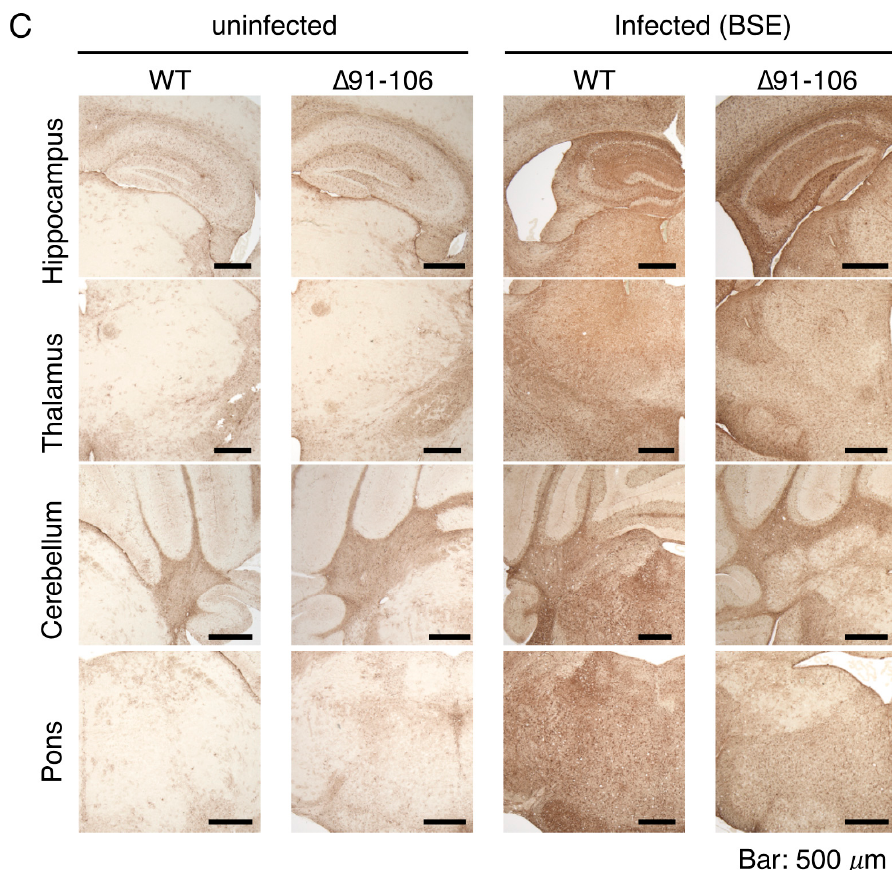
Figure 4. Pathological examinations of the brains of BSE-infected, terminally ill Tg(PrP ∆